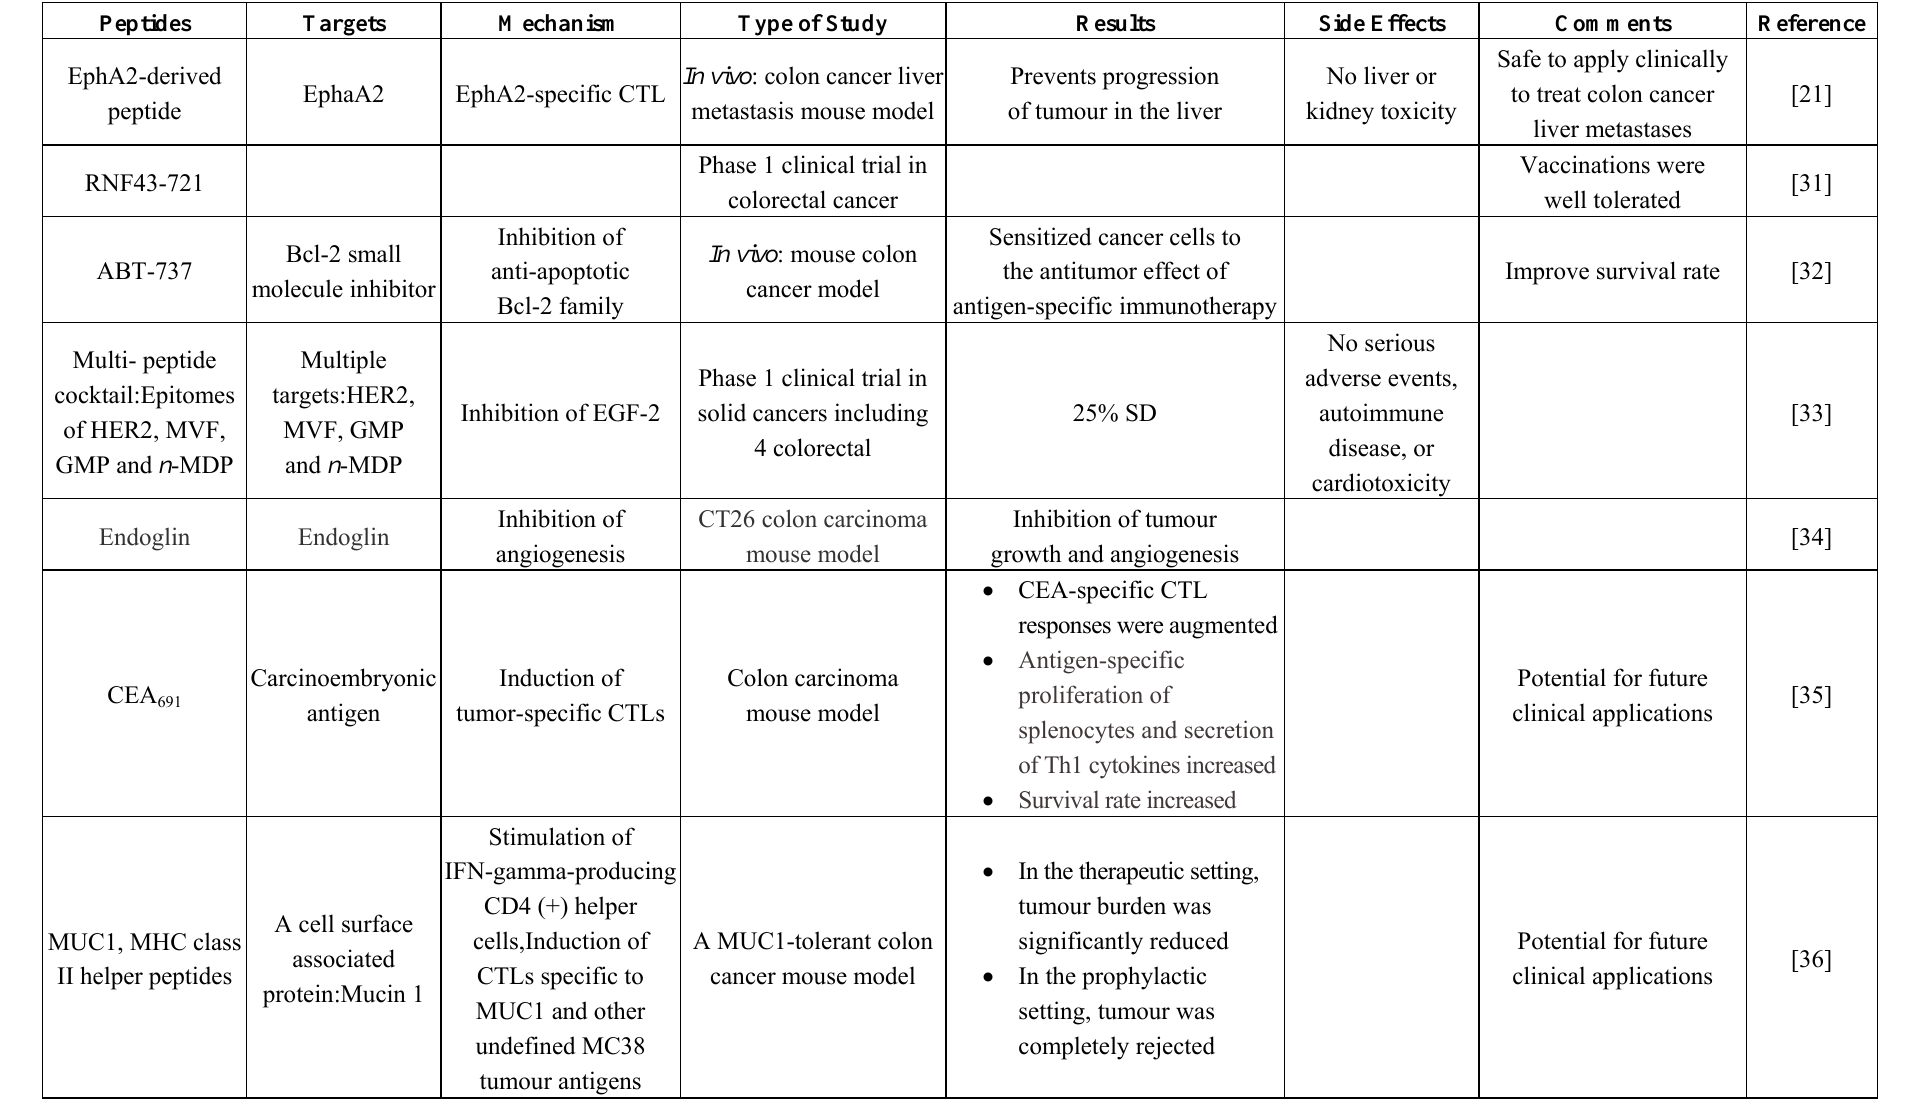
Table 1. Antigen targets in colon cancer, their biological role, results of in vivo studies and clinical trials for peptide vaccination.